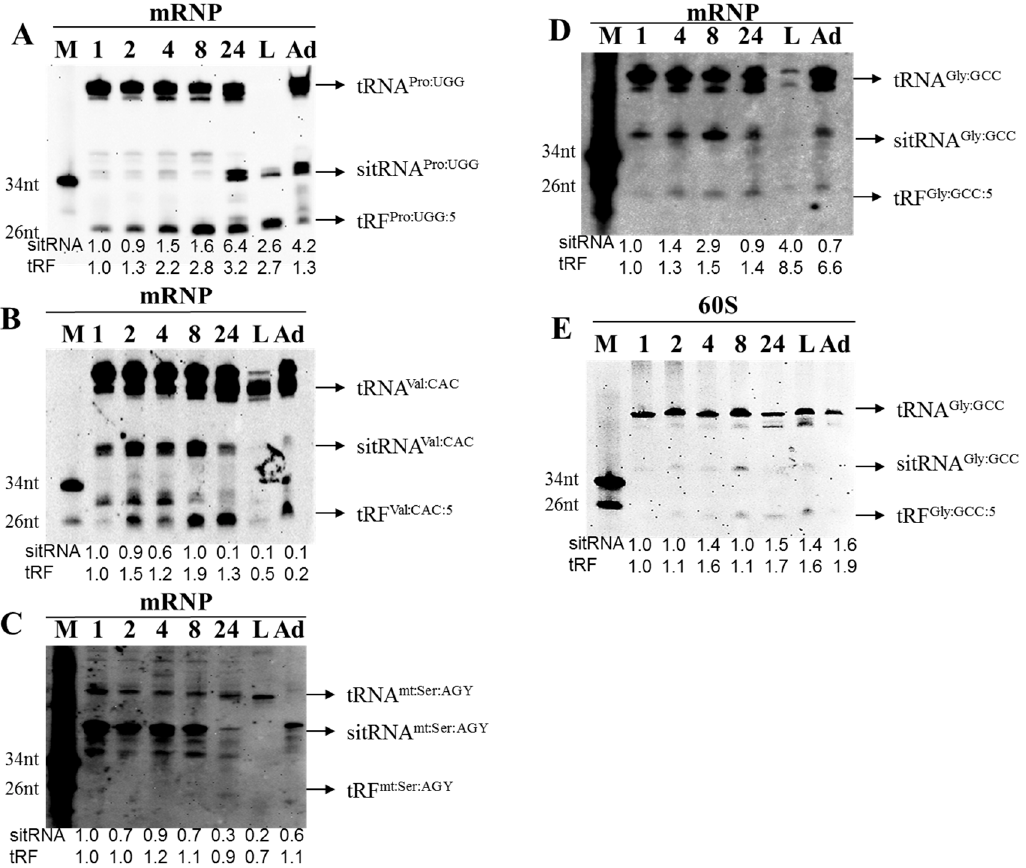
Figure 5. tRFs are differentially expressed during development in Drosophila . Polysome profiling of Drosophila samples of different developmental stages (1–24 h embryos; L—Larvae and Ad—Adult shown on top), RNA isolation and Northern blotting were performed as in Figure 2. RNA isolated from either mRNP fractions ( A – D , 5 µ g) or 60S fraction ( E , 15 µ g) was used in blotting. Data were normalized first against the mature tRNA levels and then to 1h embryos to calculate fold of induction for sitRNA and tRFs. The sitRNA and tRF expression ratios are based on signal intensity. Mature tRNA (tRNA XXX ), stress-induced tRNA fragments (sitRNA XXX ) and tRNA-derived fragments (tRF XXX ) are shown to the right. M—Marker (size shown on the left).